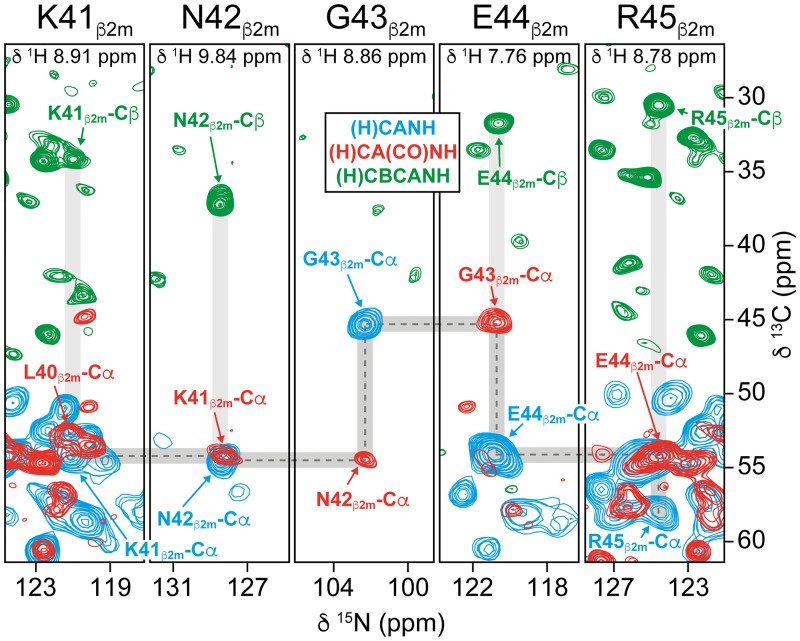
Triple-resonance MAS NMR spectra enable assignments of chemical-shifts.Sequential resonance assignments using the experiments (H)CANH (blue), (H)CA(CO)NH (red), and (H)CBCANH (green) recorded on fully protonated [13C,15N]-labeled FcRnECD at 100 kHz MAS. As an example, the sequential connections from K41β2m to R45β2m in β2m are indicated by dashed lines. All assigned chemical-shifts can be found in S1 Table, S2 Data, and in the BMRB (accession number 27437). β2m, β2-microglobulin; BMRB, Biological Magnetic Resonance Data Bank; FcRnECD, extracellular domain of the neonatal Fc receptor; MAS, magic-angle-spinning.